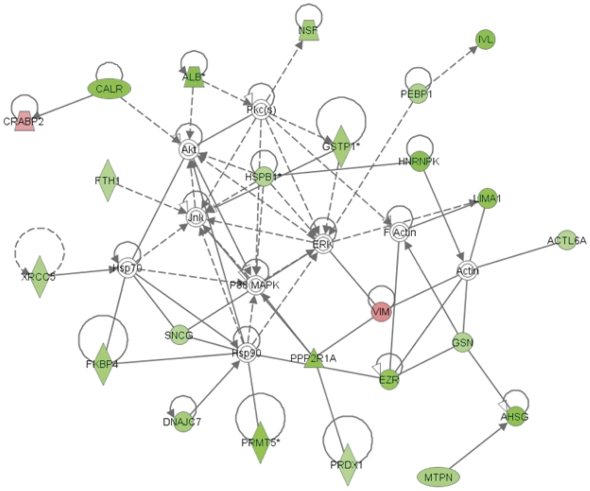
Protein networks associated with the proteins differentially expressed in response to HIV and/or HAART.The network was generated by Ingenuity pathway analysis (IPA) software using the list of differentially expressed proteins identified by 2-D DIGE/MS analysis. Individual proteins are represented as nodes, and the different shapes of the nodes represent the functional class of the proteins. The edges define the relationships of the nodes: the arrowheads indicate the direction of the interaction.